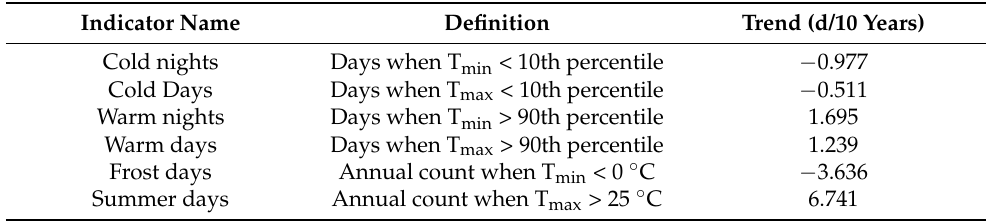
Table 1. Trends of extreme temperature indices over the Hindu-Kush Himalaya region in the period 1961–2015. Source: Sun et al.